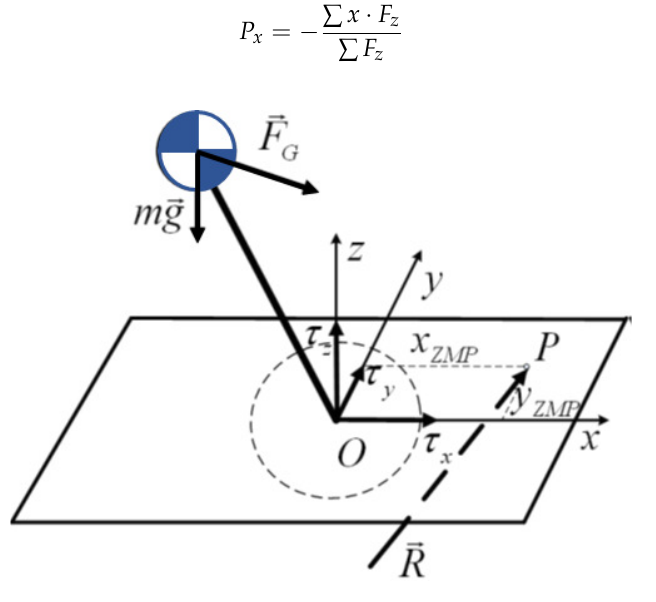
Figure 6. The ZMP location ( P